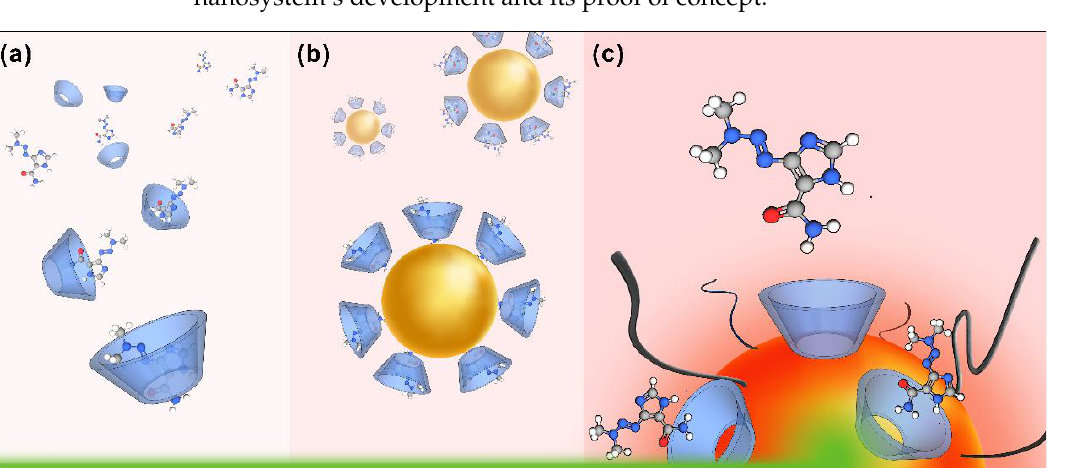
Figure 1. Schematic representation of the development of the PEG-AuNPs-CD@DB nanosystem: ( a ) formation of the CD@DB complex by drug inclusion into the cyclodextrin cavity, ( b ) coating of the AuNPs surface with the CD@DB complexes, and ( c ) release of the DB from the nanosystem triggered by laser irradiation.